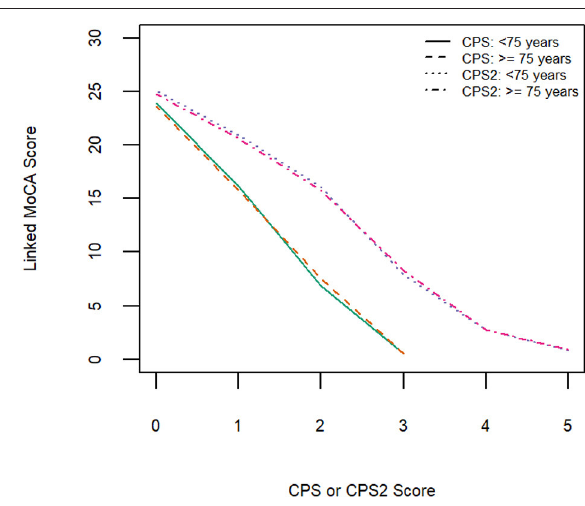
FIGURE 3 | Equipercentile linking function from CPS and CPS2 to MoCA-5min in three education groups.